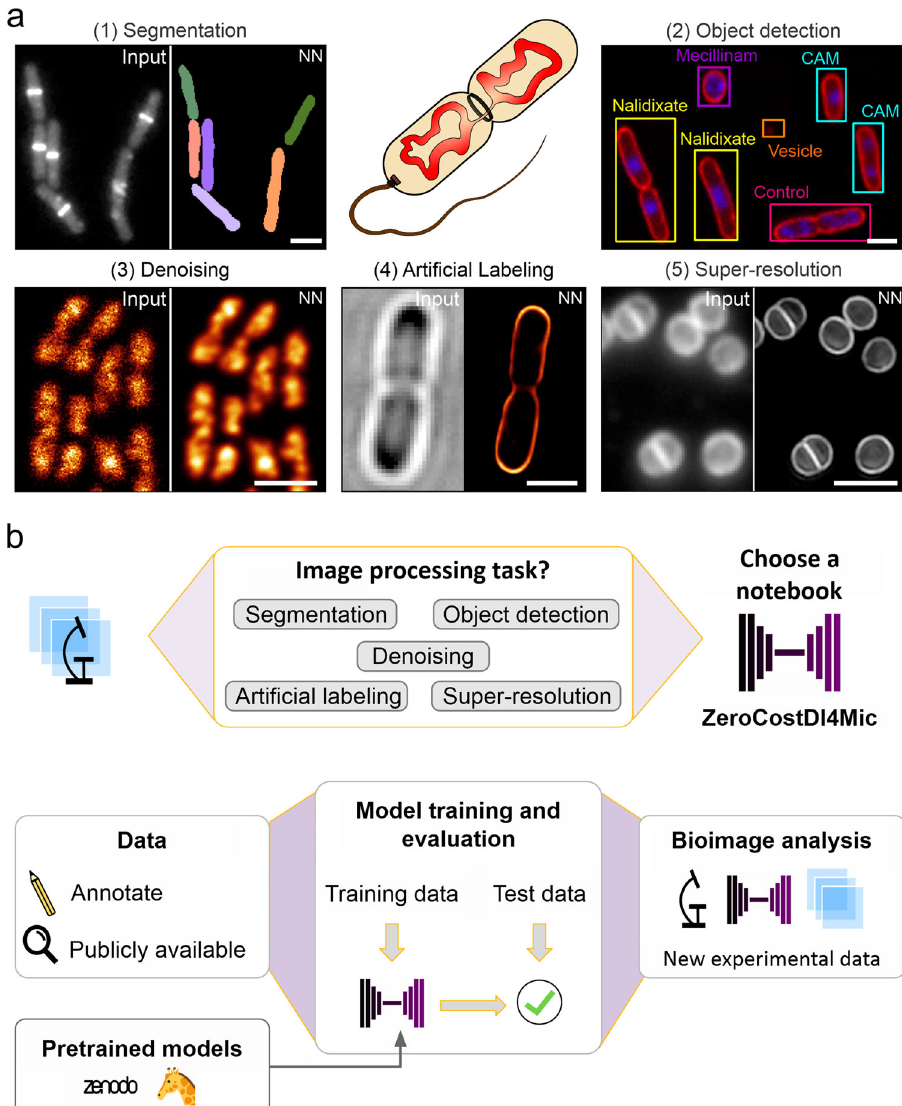
Fig. 1 Overview of the DL tasks and datasets used in DeepBacs. a We demonstrate the capabilities of DL in microbiology for segmentation (1), object detection (2), denoising (3), arti fi cial labelling (4) and prediction of super-resolution images (5) of microbial microscopy data. A list of datasets can be found in Supplementary Table 1, comprising different species such as B. subtilis (1), E. coli (2 – 4) and S. aureus (5) and imaging modalities (wide fi eld (1,2) and confocal (2,3) fl uorescence microscopy, bright fi eld imaging (1,2,4) or super-resolution techniques (4,5)). NN: neural network output. CAM = Chloramphenicol. Scale bars: 2 µ m. b Schematic work fl ow of applying a DL network. Users select a ZeroCostDL4Mic notebook based on the image analysis task to be performed. Custom annotated or publicly available datasets are used to train and validate DL models. The user can train the DL model from scratch or load a pretrained model from public repositories (e.g., Zenodo or BioImage Model Zoo 77 ) and fi ne tune it. After model accuracy assessment, trained models can be applied to new experimental